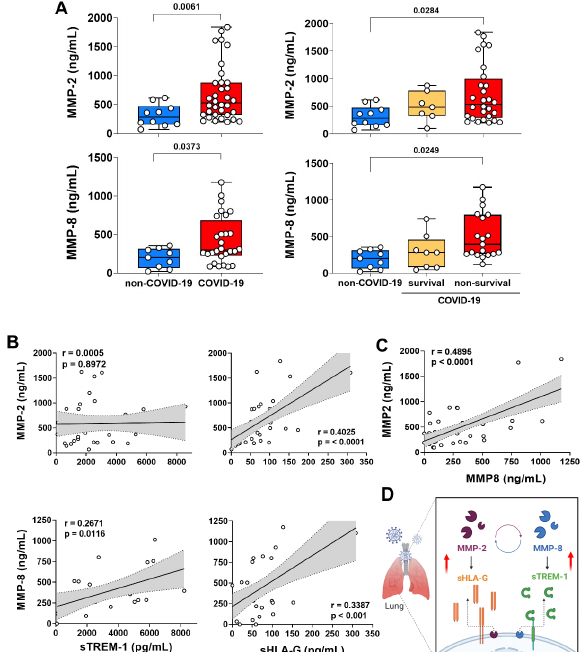
Figure 2. Increased levels of MMP-2 and MMP-8 in TAF samples correlated with non-survival COVID-19 and shed of sHLA-G and sTREM-1. ( A ) Quantification of MMP-2 and MMP-8 in TAF samples from non-COVID-19 ( n = 13) and COVID-19 patients (survival n = 6, non-survival n = 33). Statistical analyzes were performed using the Kruskal–Wallis multiple comparison test, followed by the Dunns post-test to compare pairs. Data are expressed as median with 95% confidence inter- vals. Statistical differences between groups are considered by p < 0.05 and represented directly in the graphic figure. ( B ) Correlations between MMP-2 and MMP-8 levels and soluble immune factors sHLA-G and sTREM-1 in total TAF samples from non-COVID-19 and COVID-19 patients at hospital admission. ( C ) Correlations between MMP-2 and MMP-8 levels in total TAF samples from non- COVID-19 and COVID-19 patients at hospital admission. Spearman correlation analysis, r and p value indicated in each panel. ( D ) Schematic representation of the MMP-2 and MMP-8 positive looping inducing the release of sHLA-G and sTREM-1 in lung from severe COVID-19. (Created with BioRender.com, Agreement number: IZ23RHRAES).